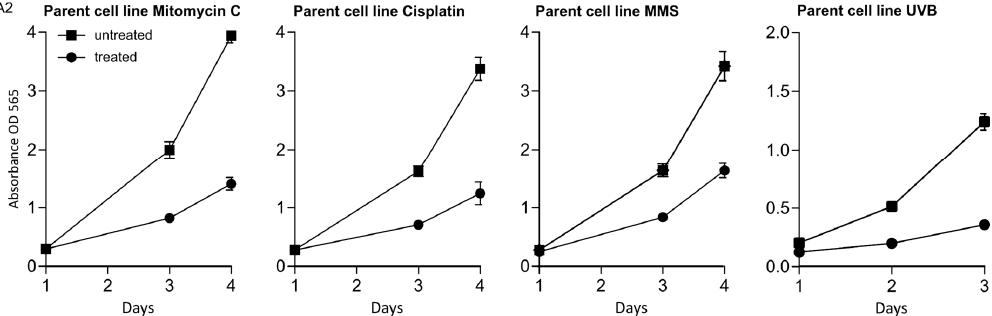
Figure A2. Viability of parent cell line untreated and treated with MMC (0.05 μ M), Cisplatin (1 μ M), MMS (50 μ M) or UVB (50 mJ/cm 2 ) determined by MTT on day 1, 2 and 3 (treated on day 0). Related to Figure 1 .